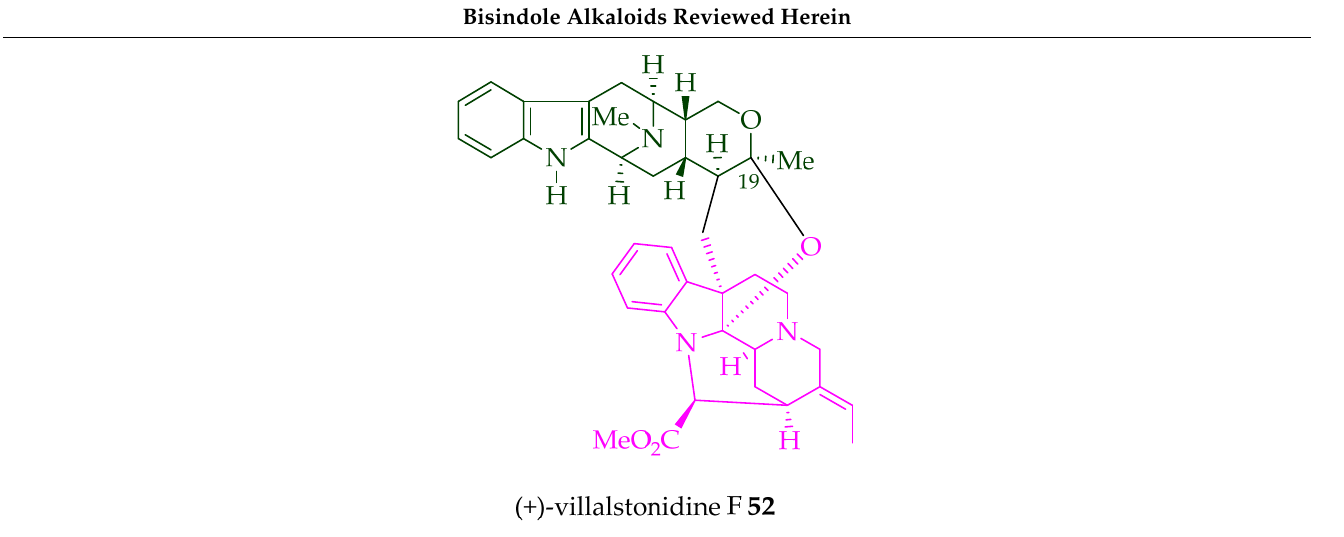
Table 3. Isolation and plant morphology of bisindole alkaloids from Alstonia